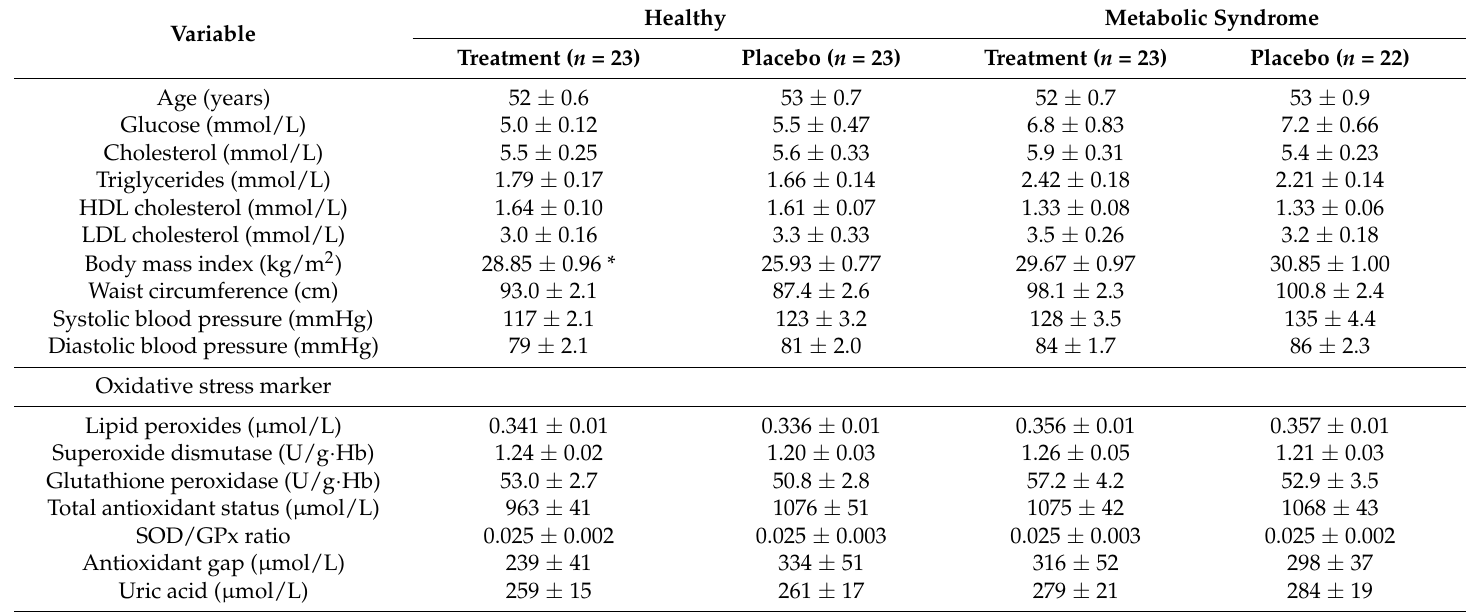
Table 1. Baseline parameters and oxidative stress markers of study